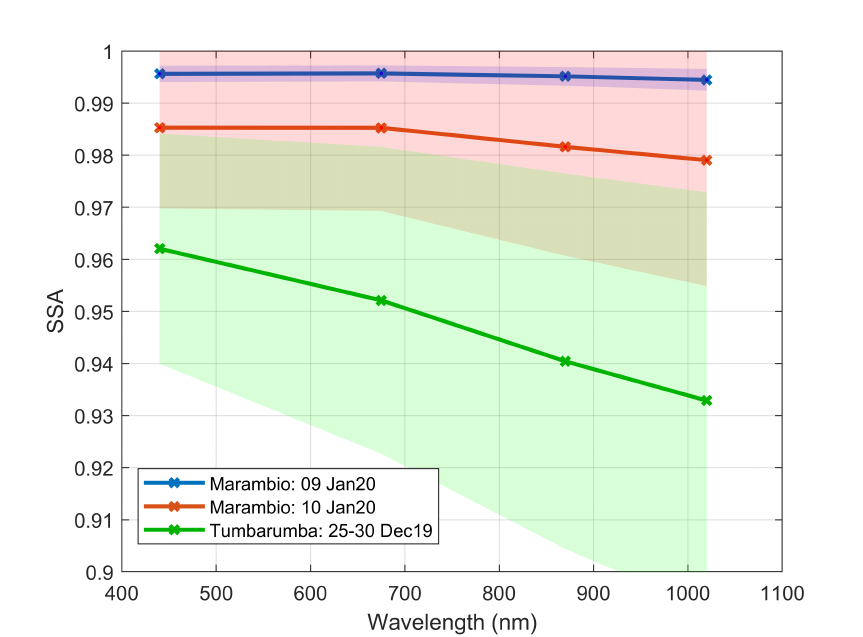
Figure 8. Single scattering albedo (SSA) as a function of wavelength over Marambio, Antarctica, on 9th and 10th January 2020 (daily averages), as well as the mean of the daily averaged SSA over Tumbarumba, Australia, for the period 25–30 December 2019. Color shaded areas represent ± 1 standard